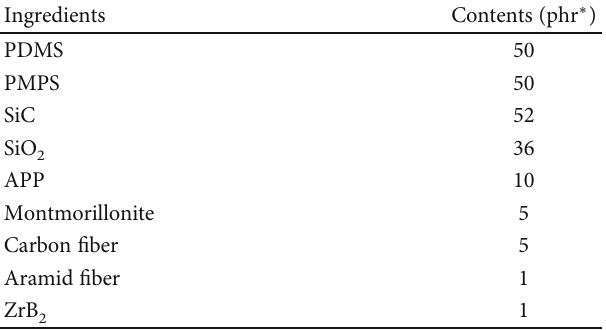
Table 1: Formula of silicone rubber insulator.